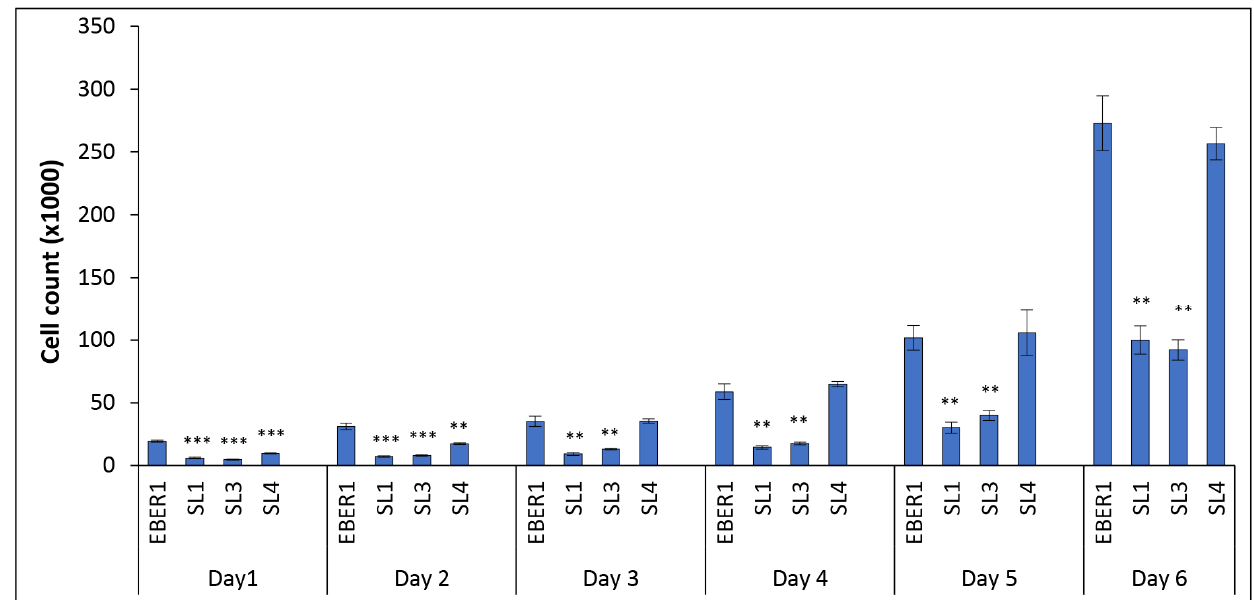
Figure 3. Impact of EBER1 structure on cell proliferation . Cell growth was monitored daily with trypan blue exclusion dye. The absolute viable cell count was normalised to the respective copy number of each construct. The result showed that ∆ SL1 and ∆ SL3 transfectants have significantly less cell growth compared to the wildtype EBER1. Each experiment was performed in duplicate and repeated four times. Data are expressed as mean ( ± SEM) of the four independent experiments, ** = p ≤ 0.01, and *** = p ≤ 0.001.